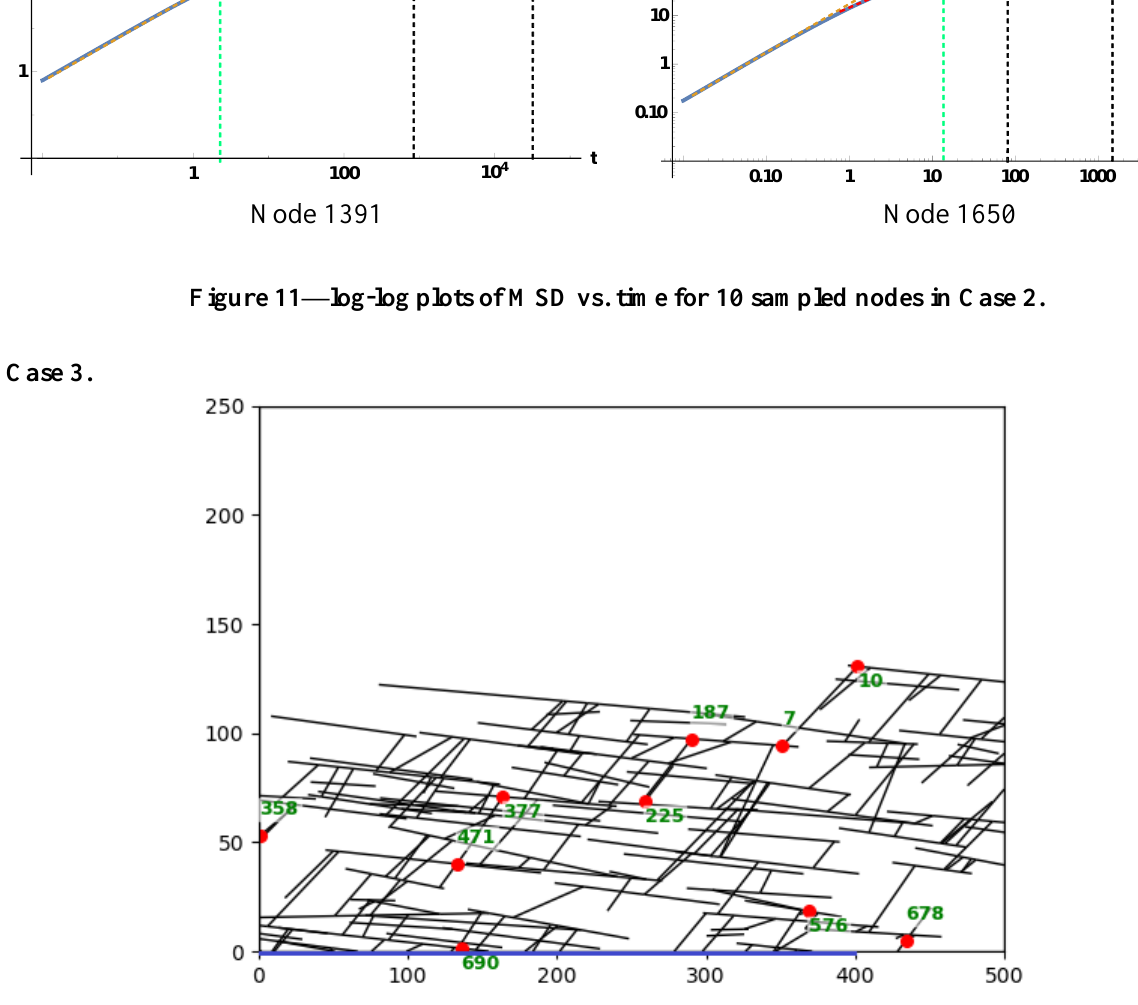
Figure 12—Map view plot of the fracture network and 10 sampled nodes in Case 3.